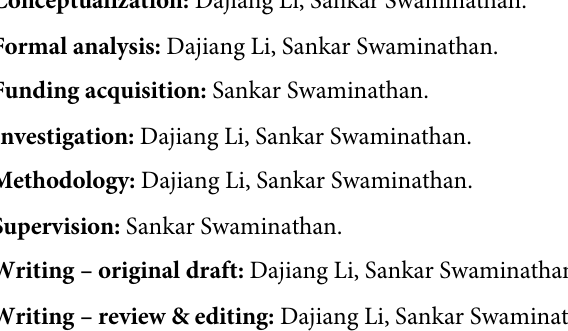
(TIF) S6 Fig. IFIT1 and IFIT3 expression in doxycycline treated TRExBCBL1-Rta cells. TRExBCBL1-Rta (uninfected by lentivirus) were untreated (-D) or treated with doxycycline (+D) to induce replication. Expression of IFIT1 (A), IFIT3 (B) or ORF57 (C) was measured by immunoblotting. iSLK/Bac16 cells were infected with six independent lentivirus clones con- taining IFIT1 shRNA (shIFIT1) or control shRNA (sh C) and IFIT1 was measured by immu- noblotting to assess efficacy of IFIT1 KD (D). TREx BCBL1 cells were infected with pooled IFIT1 shRNA lentivirus preparations or control lentivirus, and then mock-treated (-D) or treated with doxycycline (+D) to induce replication. Lysates were immunoblotted for IFIT1 (E) or IFIT3 (F). Lysates were also blotted with anti-ORF57 antibodies (G) or anti-K8.1 anti- bodies (H) to assess effects on KSHV lytic gene expression. Blots stripped and re-probed with anti-actin or anti-tubulin antibodies are shown below each panel as a loading control. (TIF) S7 Fig. MonoQ Ion exchange chromatography (A) and S200 gel filtration chromatography (B) for RtcB enzyme preparation. Purification of raw RtcB was performed by Ion exchange (MonoQ) purification (S7A Fig) followed by S200 gel filtration (S7B Fig) with unsalted buffer, high salt buffer and buffer B. Purified RtcB was eluted and diluted to in buffer B with 0.5% Tri- ton X-100, aliquoted and stored at -80˚C.